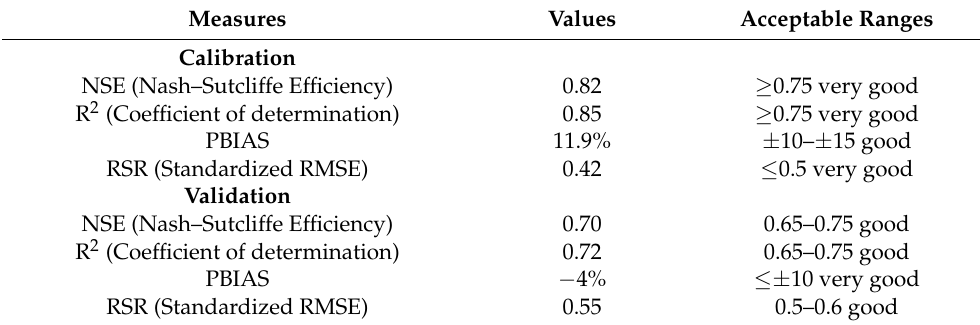
Figure 5. Comparison of observed and simulated monthly streamflow during ( a ) the calibration (between 1982 and 1987); and ( b ) validation (between 2006 and 2010) in the Uberaba River basin. Table 4. Goodness-of-fit indicators for monthly calibration between 1982 and 1987 and the validation of streamflow between 2006 and 2010 in the Uberaba River